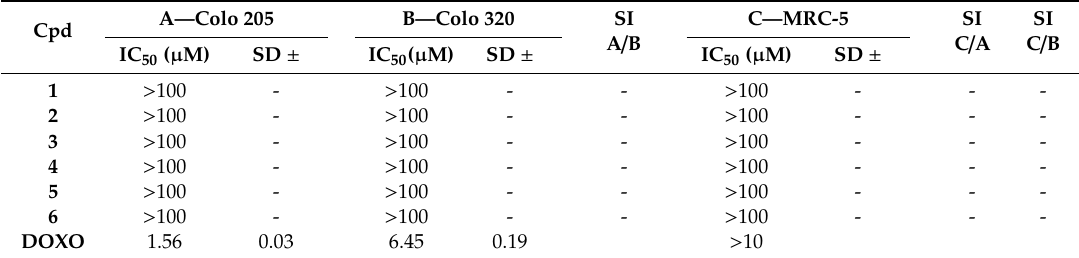
Table 1. Cytotoxic activity of flavones, thioflavones, and selenoflavones (and bioisosteric analogues).